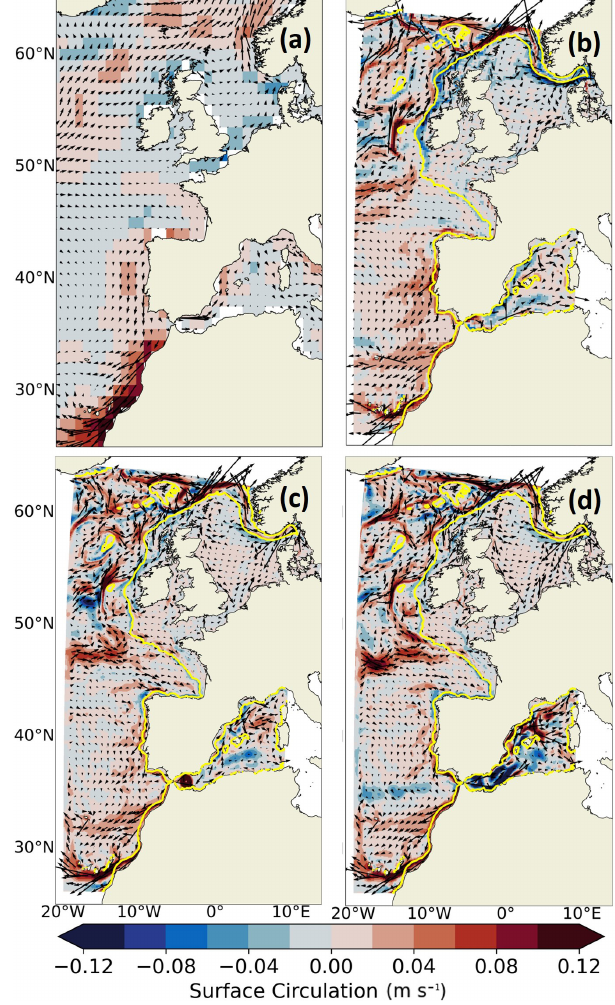
Figure 10. Projected changes in surface ocean currents (in ms − 1 ) for the 2081–2100 period (relative to 1986–2005) under the SSP5- 8.5 scenario for (a) CNRM-CM6-1, (b) CNRM-CM6-1-HR, (c) IBI-CCS_raw and (d) IBI-CCS_corr. The magnitude of surface cur- rents changes is indicated by the color shading. The shelf break (de- fined by the 200m isobath) is indicated in